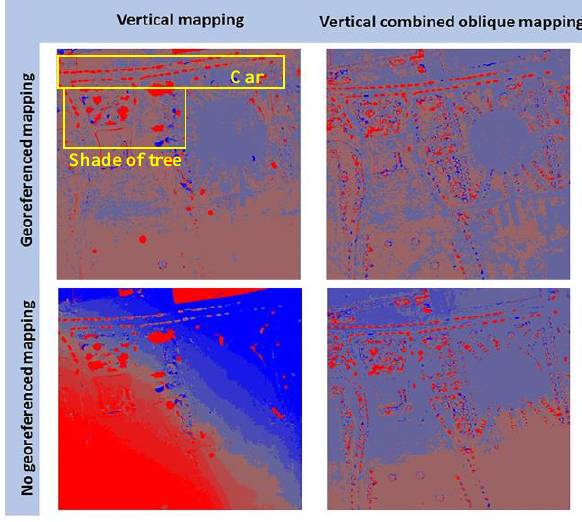
Figure 8. DSM mapping change